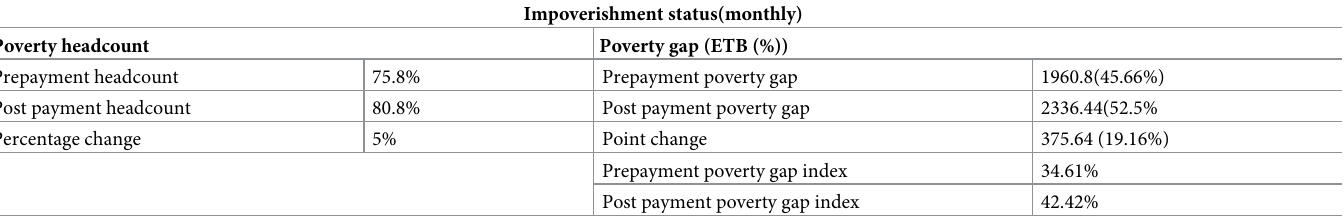
Table 5. Average monthly poverty headcount and gap before and after paying for diabetic among diabetic patients in public hospitals of Bahir Dar City administra- tion, Ethiopia,